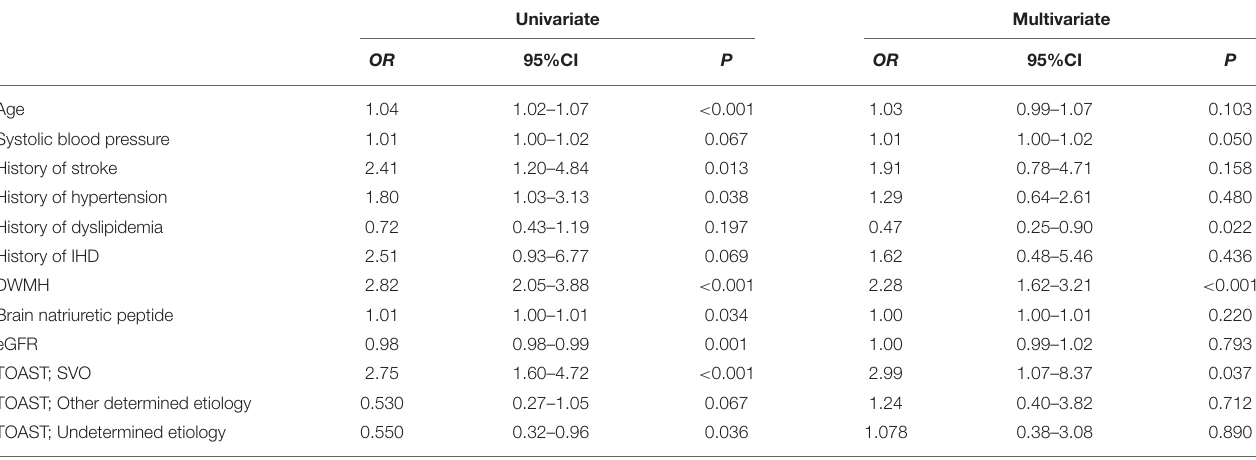
TABLE 2 | Univariate and multivariate logistic regression analyses for the presence of cerebral microbleeds. Univariate Multivariate OR 95%CI P OR 95%CI